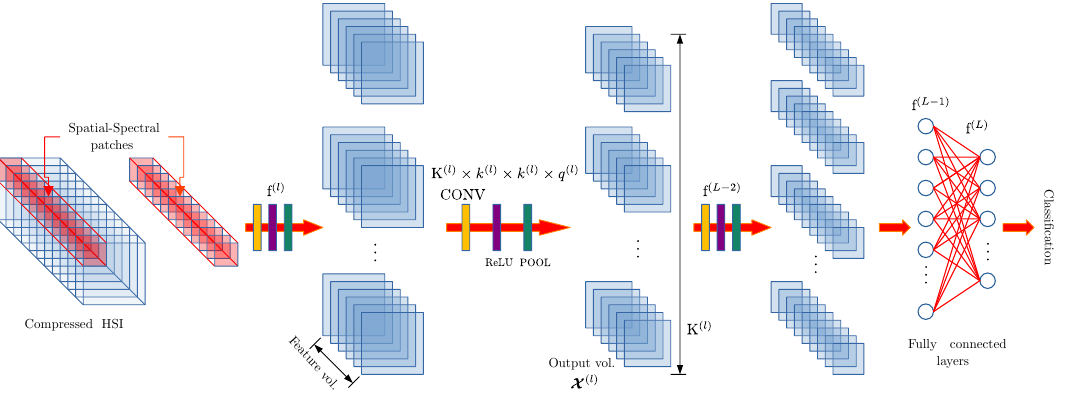
creating features volumes from a pixel of interest, and, additionally, contains